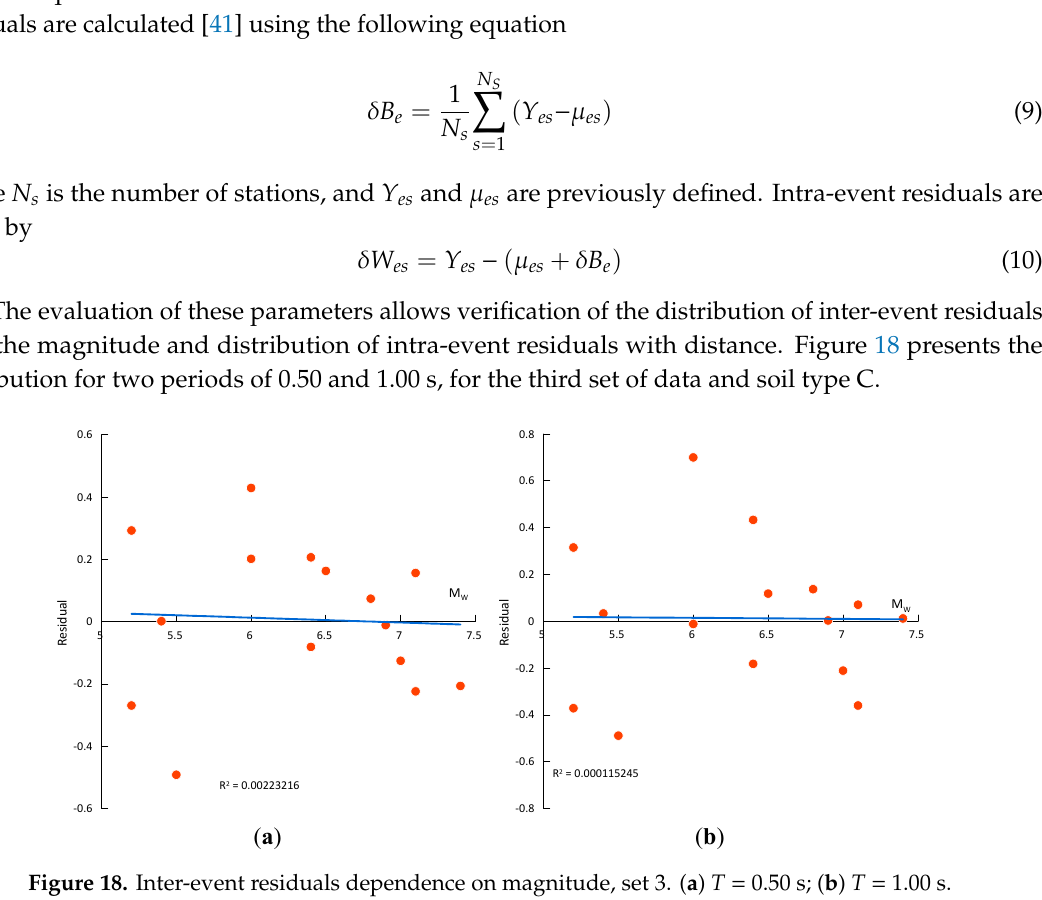
( b ) Figure 19. Dependence with distance of intra-event residuals, set 3. ( a ) T = 0.50 s; ( b ) T = 1.00 s.